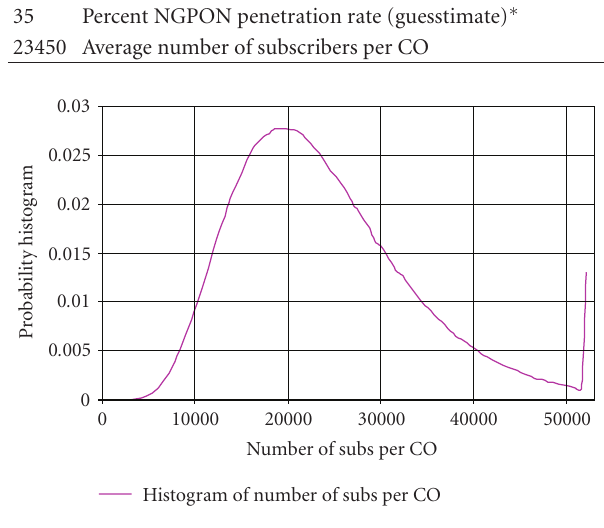
Figure 4: Model of CO-serving area